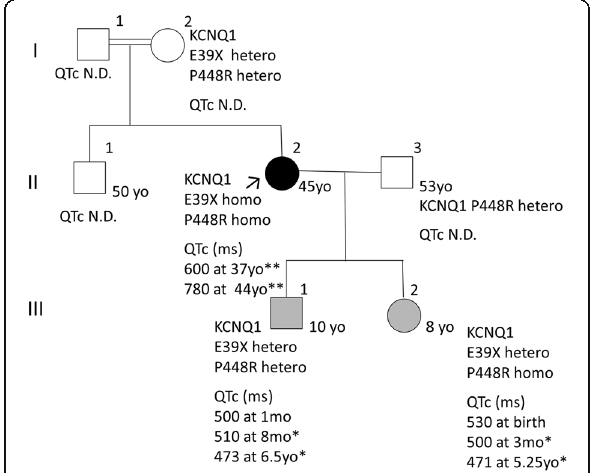
Fig. 2 Pedigree of the family. The proband is indicated by a black filled circle and an arrowhead. Squares denote males, and circles denote females. Hatched squares or circles denote significant QTc prolongation. QTc intervals are provided for each individual. *, QTc was measured under beta-blocker treatment (metoprolol). **, QTc was measured under treatment with beta-blockers (atenolol and bisoprolol) and other medication (mexiletine). E39X and P448R, nonsense variant (NM_000218.2:c.115G > T) or common variant (NM_000218.2:c.1343C > G) in the KCNQ1 gene. mo., months old; yo., years old; hetero, heterozygous; homo, homozygous; ms, millisecond; N.D., not